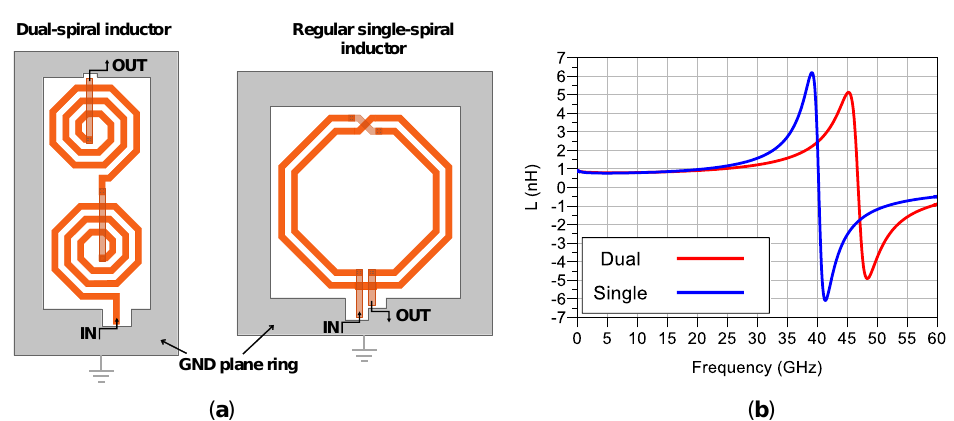
Figure 3. Compact inductor design used in the input LC high-pass filter: ( a ) Comparison of dual- spiral inductor design, where two inductors with opposite winding directions are connected in series, with a regular single spiral inductor; ( b ) inductance as a function of frequency for the dual and single-spiral inductors obtained by electromagnetic simulation, where the self-resonance frequencies for each design are observed.